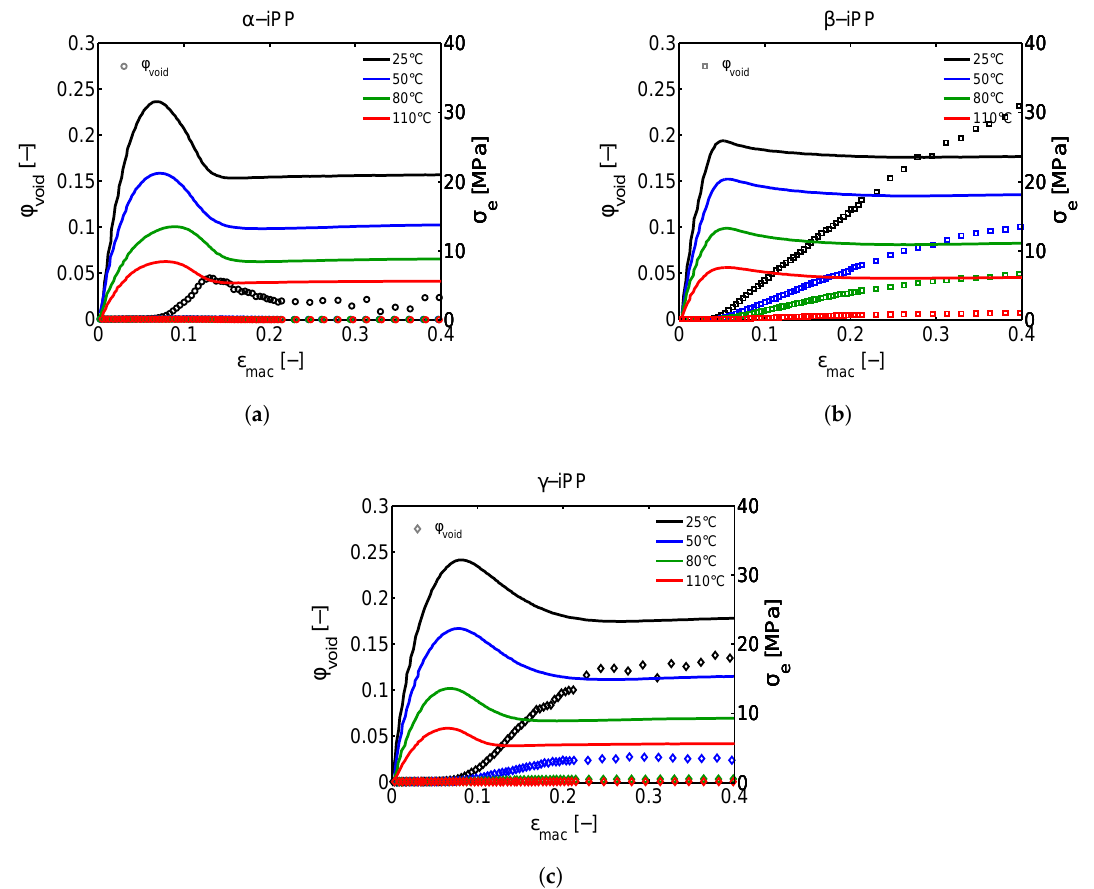
Figure 27. Void volume fraction as a function of the macroscopic strain for α -iPP ( a ), β -iPP ( b ) and γ -iPP ( c ), elongated at 25, 50, 80 and 110 ◦